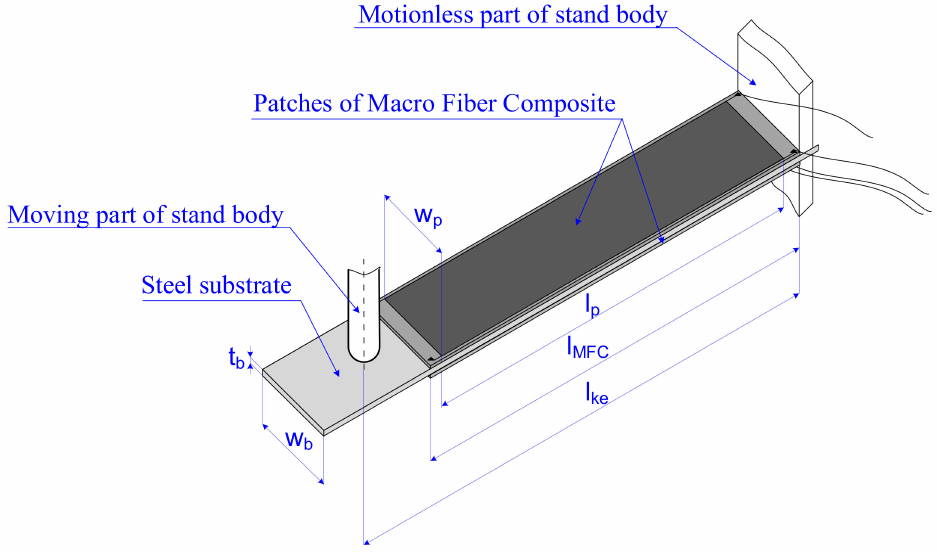
Figure 3. Structure of manufactured bimorph. Geometric parameters of manufactured bimorph are presented in Table